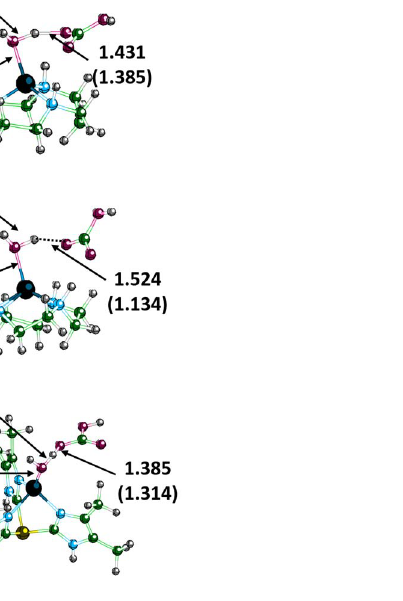
Figure 8. Calculated transition state structures (TS3) for displacement of bicarbonate by a water molecule for N3-Zn (A), N4-Zn (B), and Ph-Zn (C). Numerical values are in angstroms and values in parenthesis are the corresponding values for the cobalt structures.